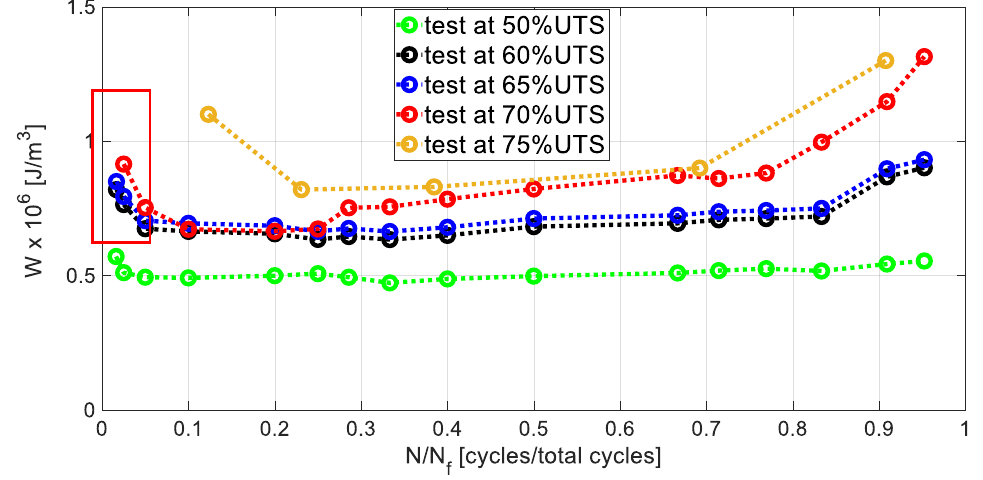
Figure 5. Evolution of W through N / N f for each stress level.